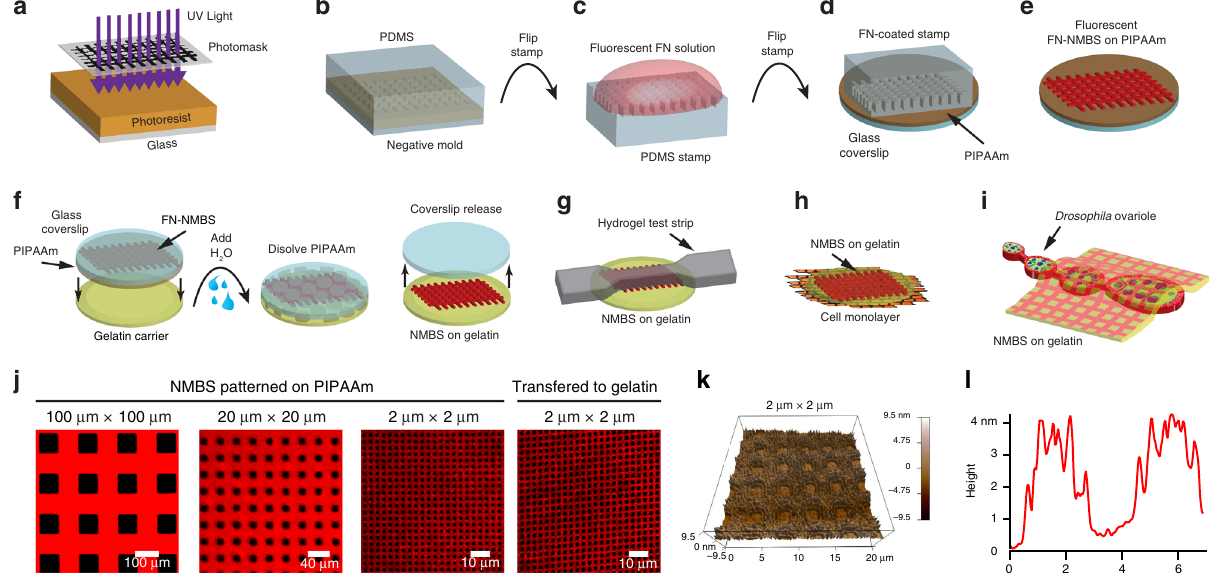
Fig. 1 Microfabrication, experimental set-up, and analysis of the nanomechanical biosensor (NMBS). a Exposure of photoresist-coated glass wafer to ultraviolet (UV) light through a custom mesh photomask. b Casting of polydimethylsiloxane (PDMS) over topographically patterned photoresist-coated glass wafer. c PDMS stamp coated with fl uorescently-labeled fi bronectin (Alexa-555-FN, 50 µ g/mL) solution. d FN-coated stamp is microcontact-printed onto a poly(N-isopropylacrylamide) (PIPAAm)-coated glass coverslip. e NMBS is patterned on the sacri fi cial substrate PIPAAm. f The NMBS-PIPAAm coverslip is placed NMBS-side down onto a gelatin type A carrier. Water is added to dissolve the PIPAAm and transfer the NMBS to the gelatin which releases the glass coverslip. g – i The NMBS is applied to dog bone hydrogel test strips ( g ), the top surface of cell monolayers ( h ), and the surface of Drosophila ovarioles ( i ) by placing the NMBS-gelatin carrier NMBS-side down on to the sample and raising the temperature to 37 °C to melt the gelatin and integrate the NMBS with the sample. j Alexa-647 fi bronectin NMBS of varying resolution from large 100 µ m × 100 µ m to small 2 µ m × 2 µ m mesh sizes patterned onto PIPPAm and transferred onto gelatin. k Atomic force microscopy (AFM) height retrace image showing the topology of the patterned NMBS. l Line plot from the NMBS height retrace reveals an average thickness for the fi bronectin NMBS of ~4 strain (Fig. 2d) show the microscopic deformations tracked by the NMBS mesh. The initial observation state, l 0 , is considered as the zero-strain reference con fi guration. Subsequent deformation of the NMBS, l , relative to the initial reference state, l 0 , enables (cid:2) 1 within each NMBS calculation of engineering strain as ε ¼ l l 0 segment. As a single NMBS fi lament segment between nodes of tant strain obtained corresponds to the strain along each segment.